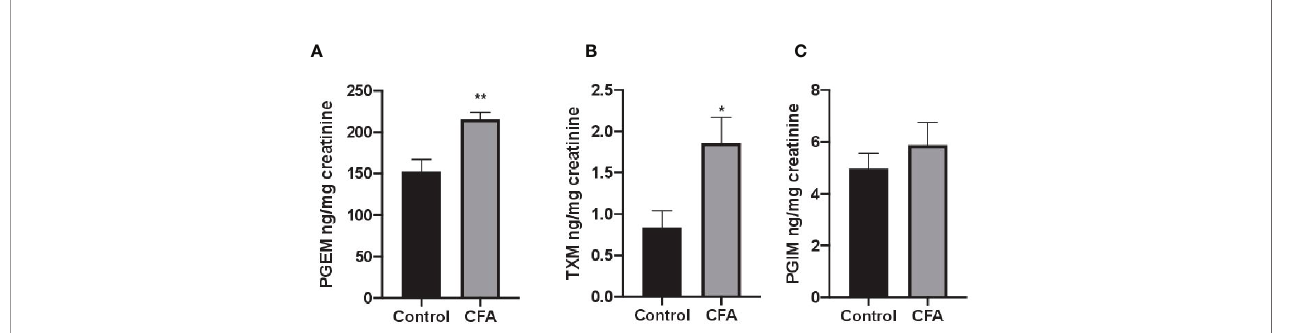
FIGURE 2 | Effects of CFA injection on the systemic biosynthesis of prostanoids in rats. The systemic biosynthesis of PGE 2 , TXB 2 , and PGI 2 was assessed by measuring their urinary enzymatic metabolites, i.e., PGEM (A) , TXM (B) and PGIM (C) , respectively, by LC-MS/MS. Data are reported as mean ± SEM (n=5 – 8). Metabolite levels were corrected for urinary creatinine and expressed as ng/mg creatinine. **P < 0.01, *P < 0.05 CFA injection versus control (Student's t-test). CFA, complete Freund's adjuvant; PGE 2 , prostaglandin E